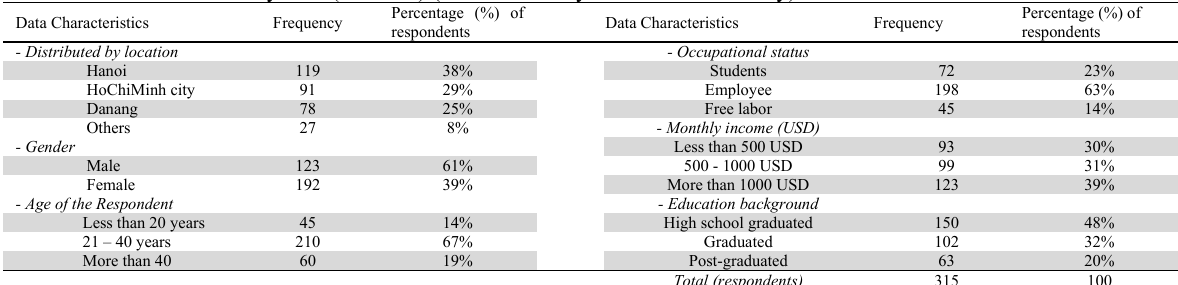
Characteristics of the survey data (N = 315) (summarized by authors from survey) Data